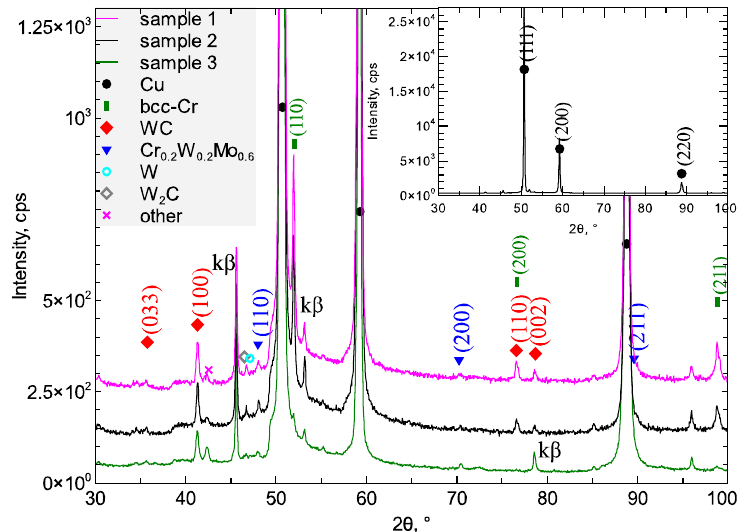
Figure 15. XRD pattern of Cu after laser alloying (sample 1: 75Cr25WC, sample 2: 50Cr50WC and sample 3: 25Cr75WC). Table 4. Calculated lattice parameters of selected crystalline phases in comparison with the litera- ture values. Lattice Parameters, a, Å, c, Å